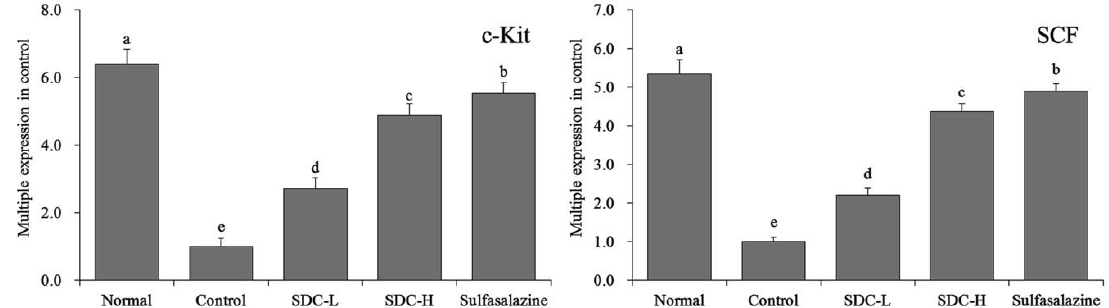
Figure 13. mRNA expression levels of c-Kit and SCF in colon tissues of mice. Values represent the mean ± standard deviation. a–e Mean values with different letters in the same bars indicate significant difference ( p < 0.05). SDC-L: 2 g/kg Shuidouchi extract treatment; SDC-H: 4 g/kg Shuidouchi extract treatment; Sulfasalazine: 20 mg/kg sulfasalazine treatment.